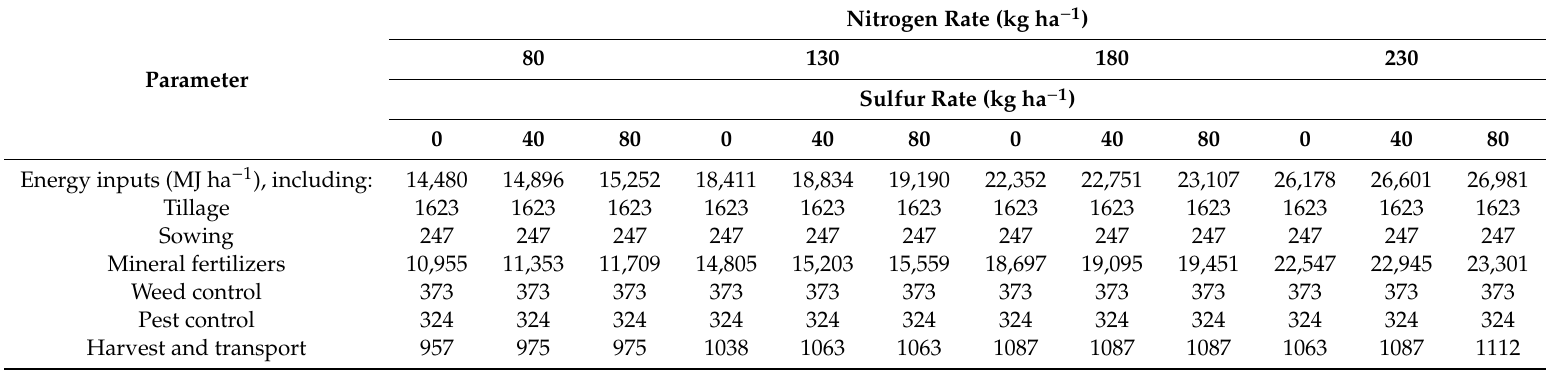
Table 11. Energy inputs in the production of the long-stem open-pollinated cultivar of winter oilseed rape (cv. Adriana), across years.